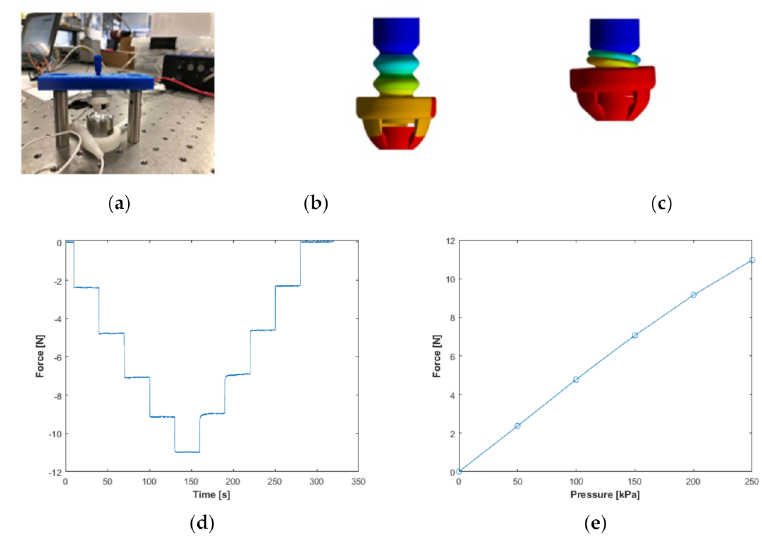
Figure 3. Blocked force measurement experimental setup and FEA comparison: ( a ) haptic unit measuring blocked force with 6 − axis force sensor, ( b ) FEM simulations in default state, ( c ) deformed state when a 9.62 mm displacement input is applied, ( d ) the soft haptic biofeedback device was subjected to variable pressure values of 50, 100, 150, 200 and 250kPa where the measured blocked forces in the transient, and ( e ) steady-state